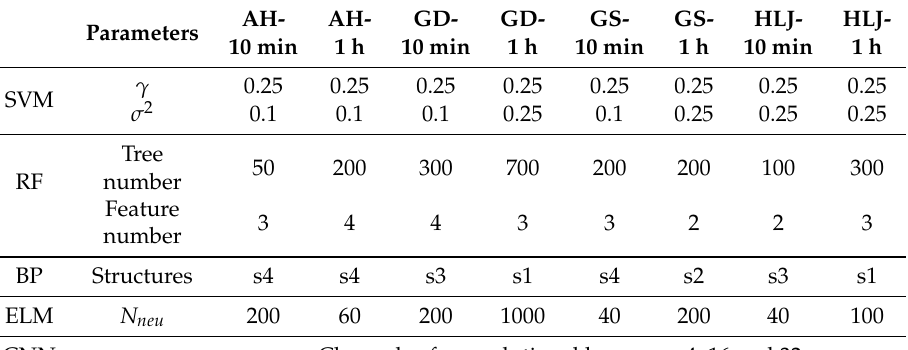
Table 5. Parameter selection results for single nonlinear models.